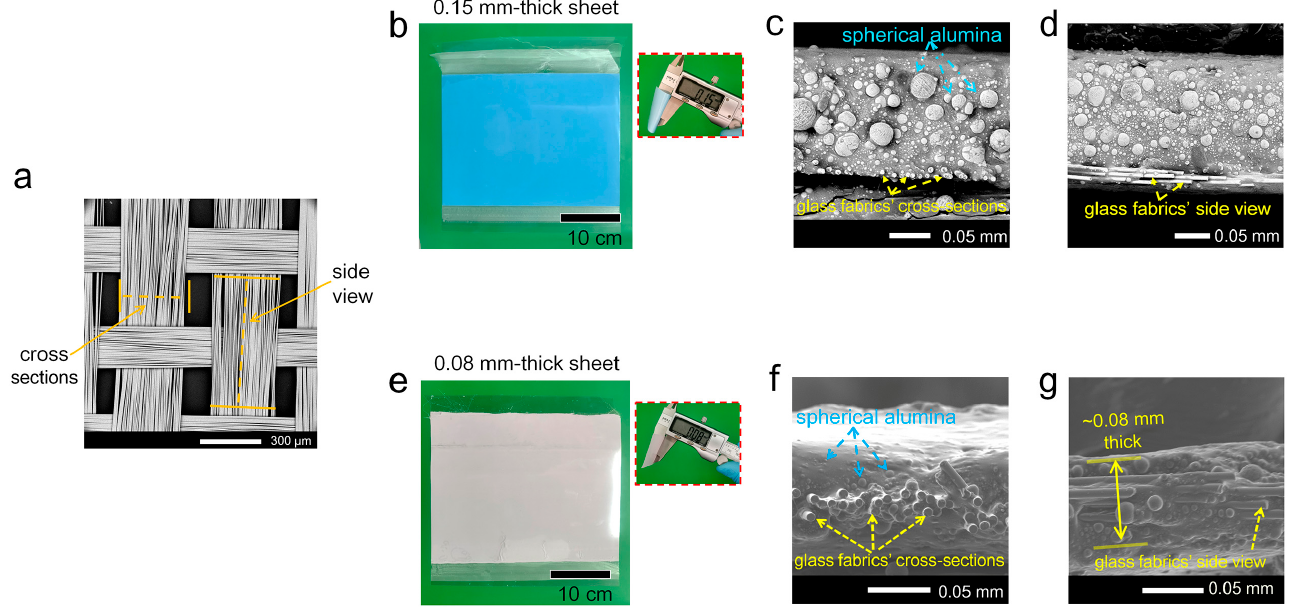
Figure 2. ( a ) SEM profile of glass fabric, and schematic diagram of the cross sections and side view of glass fabric. ( b ) Photograph of 0.15 mm-thick sheet prepared by the conventional method. ( c ) SEM profile of the 0.15 mm-thick sheet showing the cross sections of glass fabric. ( d ) SEM profile of the 0.15 mm-thick sheet showing the side view of glass fabric. ( e ) Photograph of 0.08 mm-thick sheet prepared by the low viscosity calendering method. ( f ) SEM profile of the 0.08 mm-thick sheet showing the cross sections of glass fabric. ( g ) SEM profile of the 0.08 mm-thick sheet showing the side view of glass fabric.